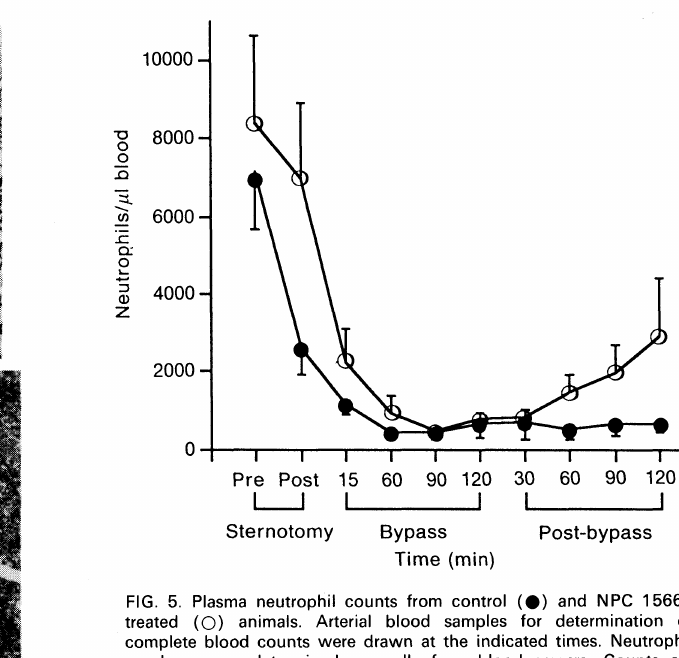
FIG. 5. Plasma neutrophil counts from control (O) and NPC 15669 treated (C)) animals. Arterial blood samples for determination of complete blood counts were drawn at the indicated times. Neutrophil numbers were determined manually from blood smears. Counts are expressed as mean _+ S.E.M. (n